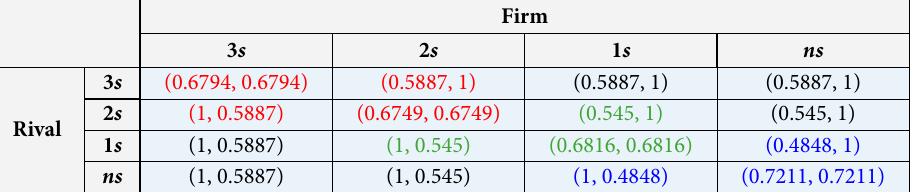
Table 5. Technological transition: two observations, risk-averse DM, and signals on X 2